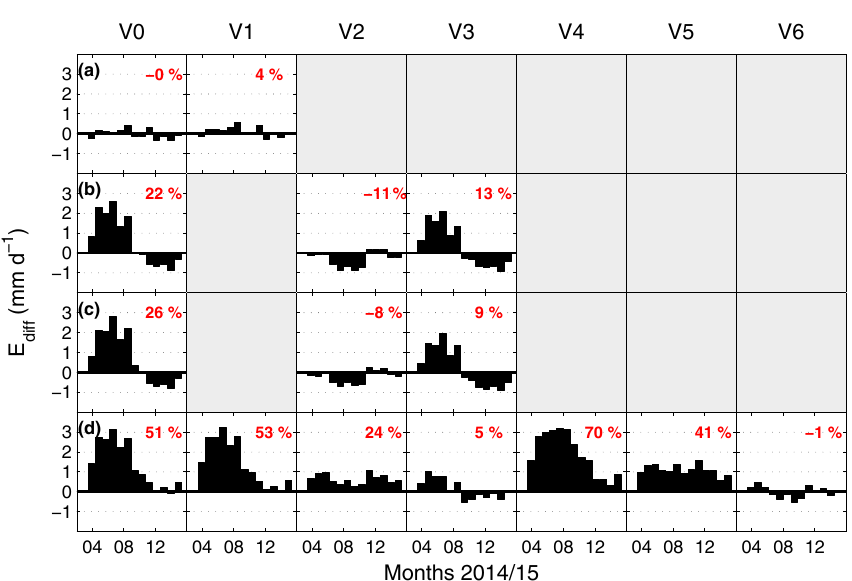
Figure 7. Differences between the estimated daily evaporation rates calculated from the 28d time averages and the measured daily evapo- ration rates for (a) the aerodynamic approach, (b) the BREB method, (c) the Priestley–Taylor equation, (d) the Penman equation, and their sensitivity studies (Table 2). The red numbers show the total deviation of the accumulated calculated annual evaporation (28d averages) from the accumulated measured